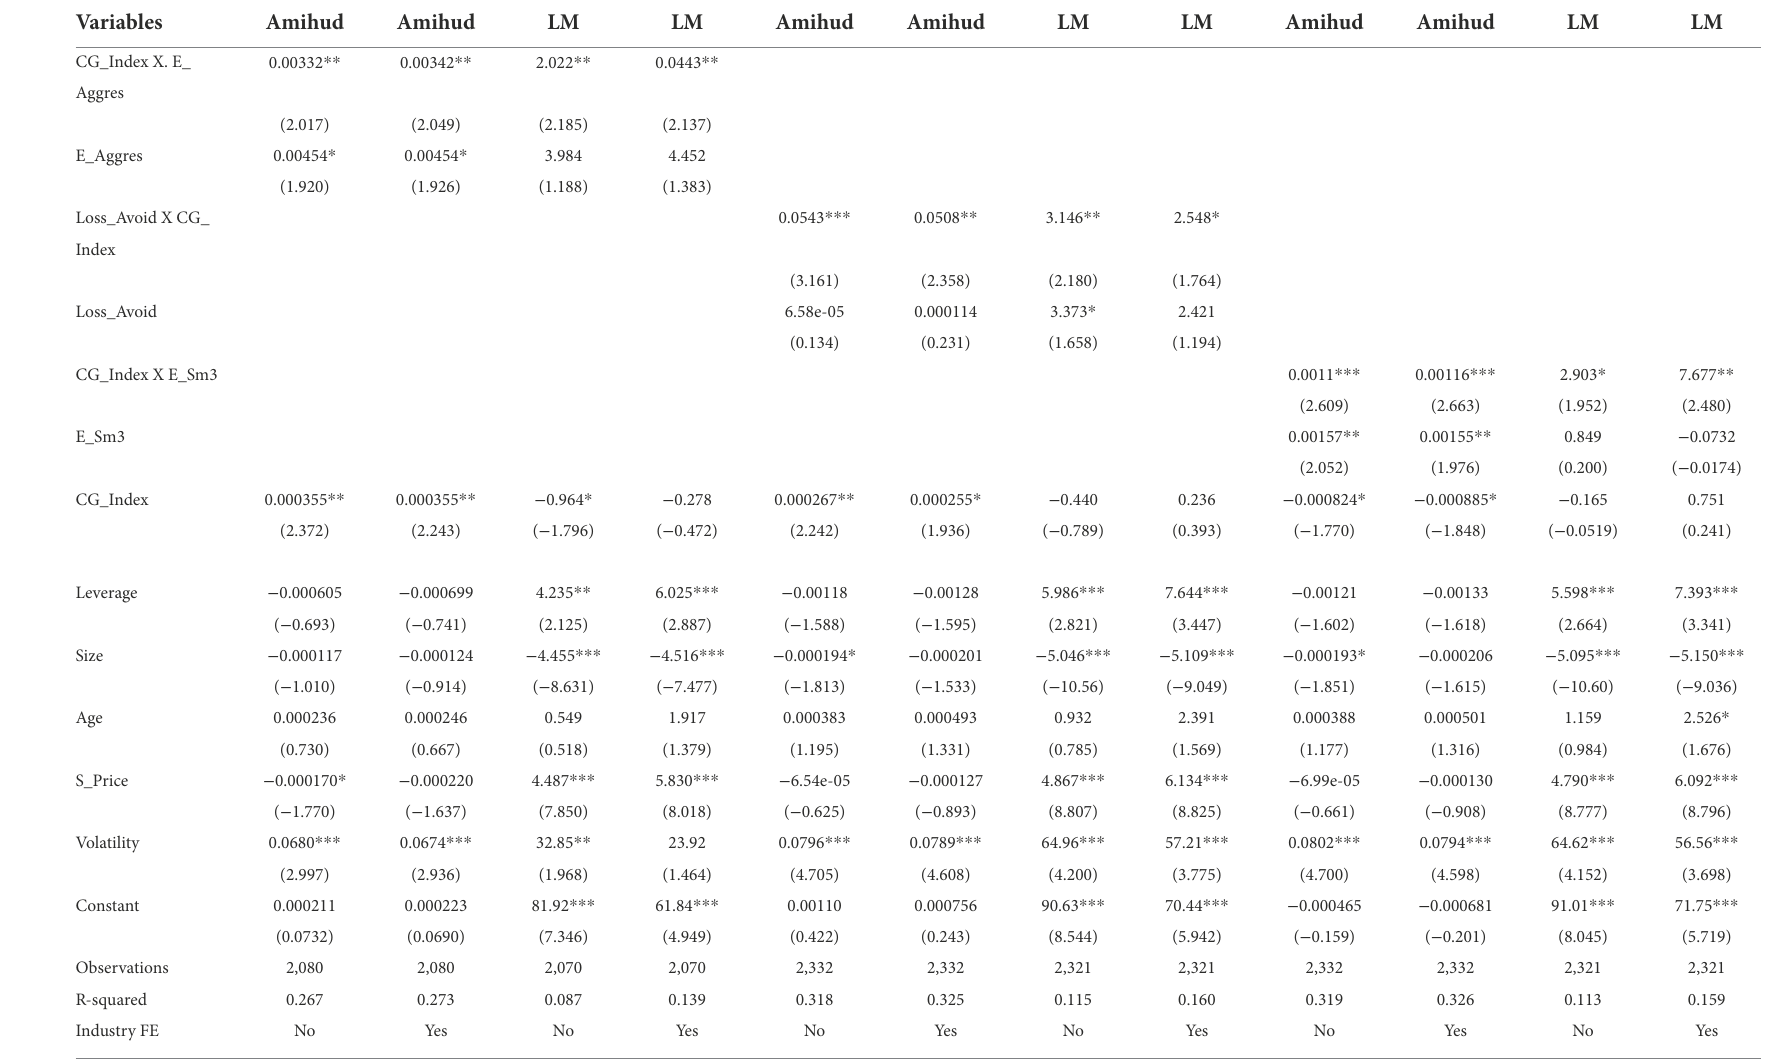
TABLE 13 CG_index, financial transparency and stock liquidity (OLS Estimation).